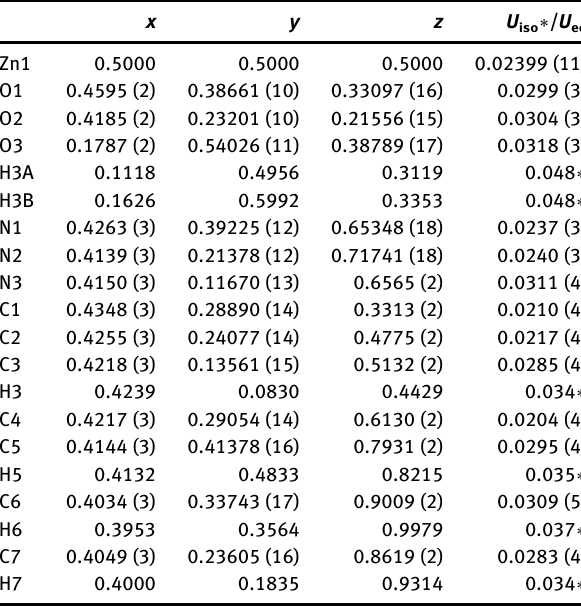
Table  : Fractional atomic coordinates and isotropic or equivalent isotropic displacement parameters (Å 